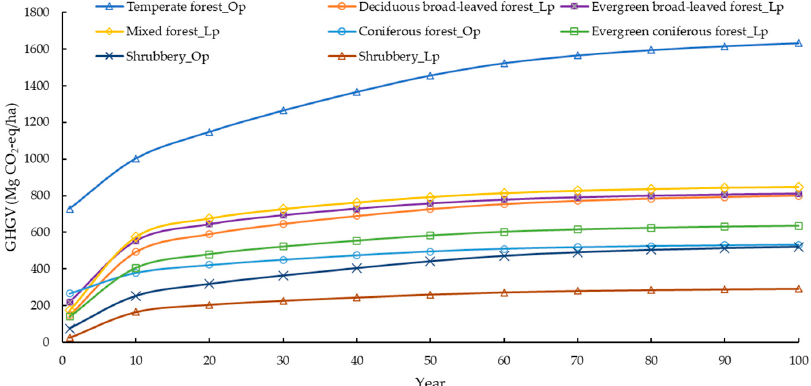
Figure 6. Temporal changes of greenhouse gas value (GHGV) in China’s forest ecosystems (GHGV with localized parameters, _Lp) and global forest ecosystems (GHGV with model original parameters, _Op).